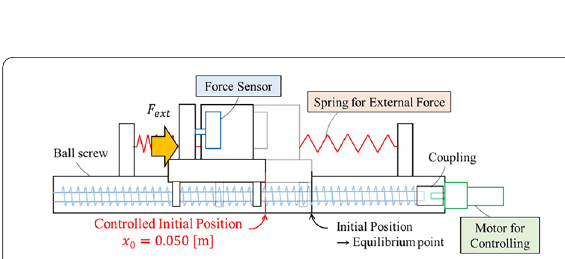
Fig. 8 Schematic of an experimental machine with one degree of